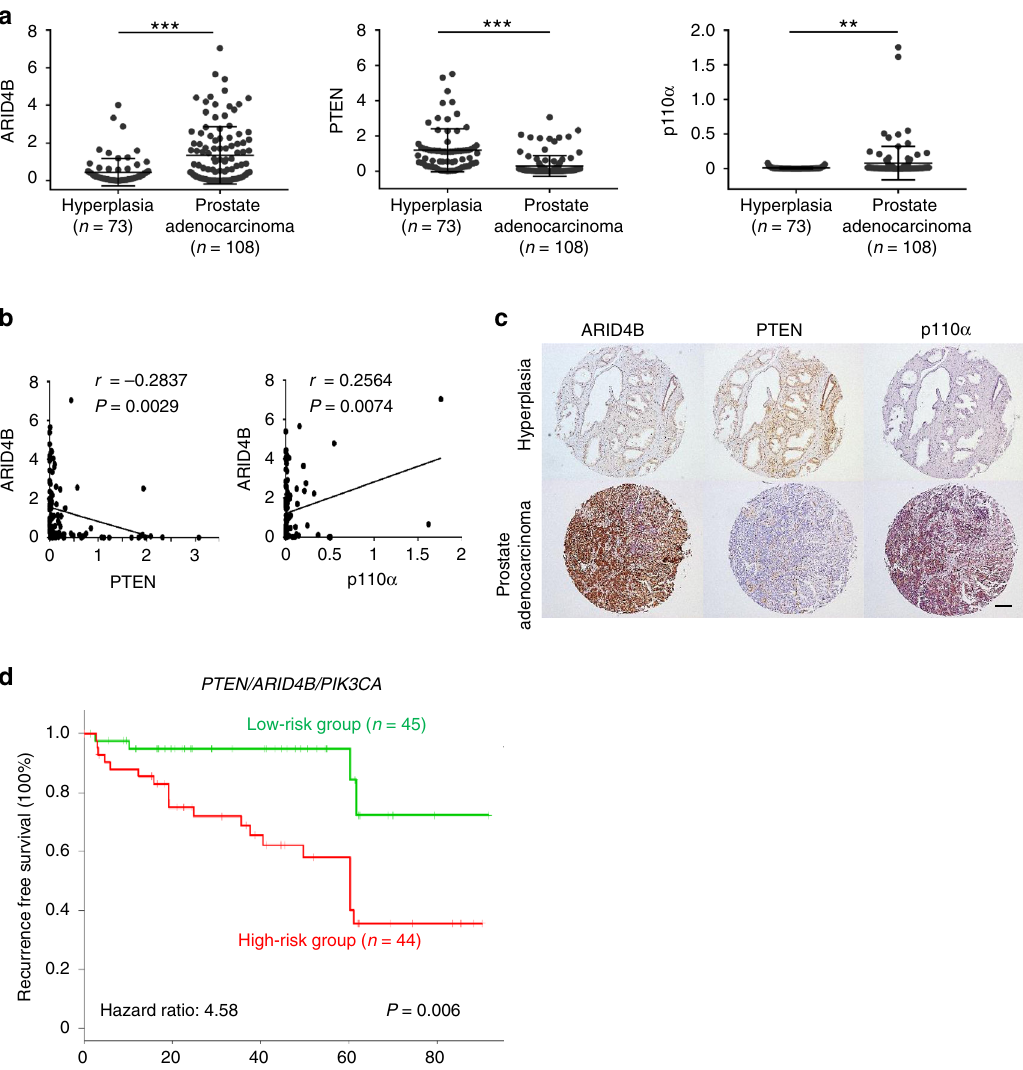
Fig. 6 Prognostic potential of the PTEN/ARID4B/PIK3CA signature in human prostate cancer. a Expression of ARID4B, PTEN, and p110 α between human prostate hyperplasia and prostate adenocarcinoma in tumor microarrays was compared. Seventy-three prostate hyperplasia samples from 36 patients and 118 prostate adenocarcinoma samples from 85 patients were analyzed. The expression levels of ARID4B, PTEN, and p110 α were presented as the numbers of positive cells (×1000) per mm 2 . b Regression plots show expression correlations of ARID4B with PTEN and p110 α in prostate adenocarcinoma from tumor microarray results. In all, 118 prostate adenocarcinoma samples from 85 patients were analyzed. The expression levels of ARID4B, PTEN, and p110 α were presented as the numbers of positive cells (×1,000) per mm 2 . c Representative immunohistochemical staining of ARID4B, PTEN, and p110 α from one patient with prostate hyperplasia (top) and one with prostate adenocarcinoma (bottom) in tumor microarrays. Scale bar, 200 μ m. d Kaplan − Meier plot of prostate cancer recurrence-free survival in patients strati fi ed by the PTEN / ARID4B / PIK3CA signature. Data are from the GSE40272 dataset. Statistical analysis: log-rank